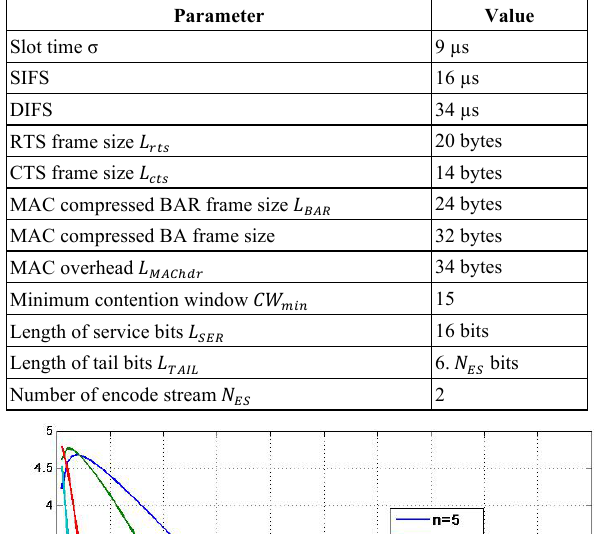
S IMULATION P ARAMETERS